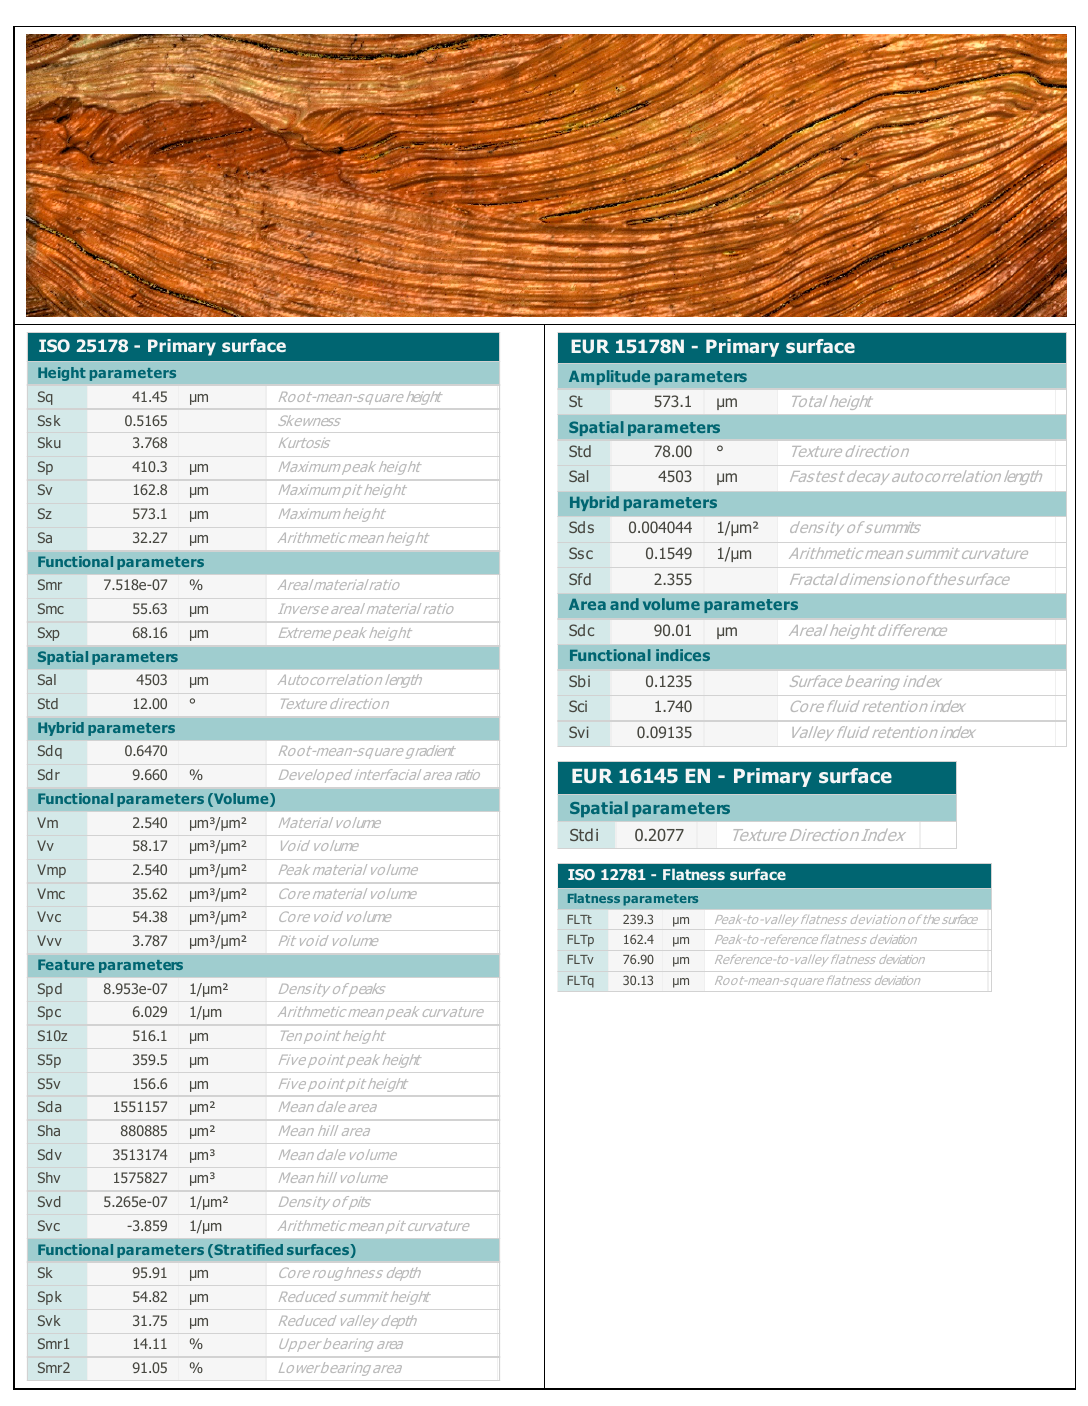
Figure A1. 3D roughness parameters values computed for a homogenous part of the petal of Van Gogh’s sunflower topography.